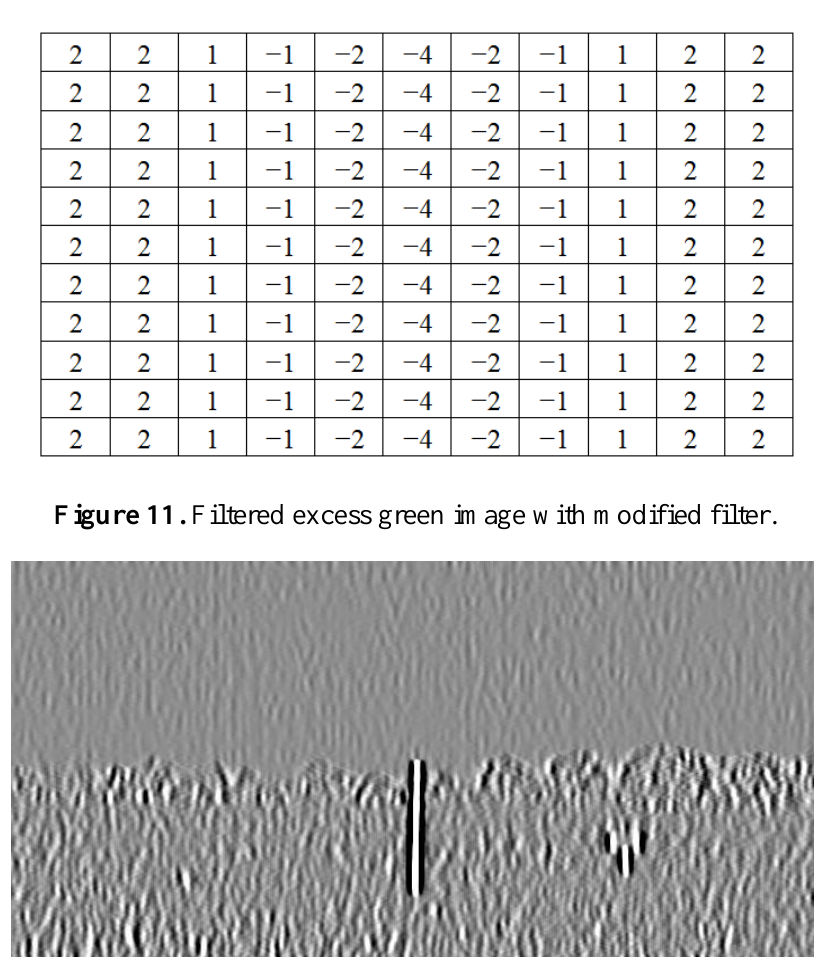
Figure 10. Modified filter.